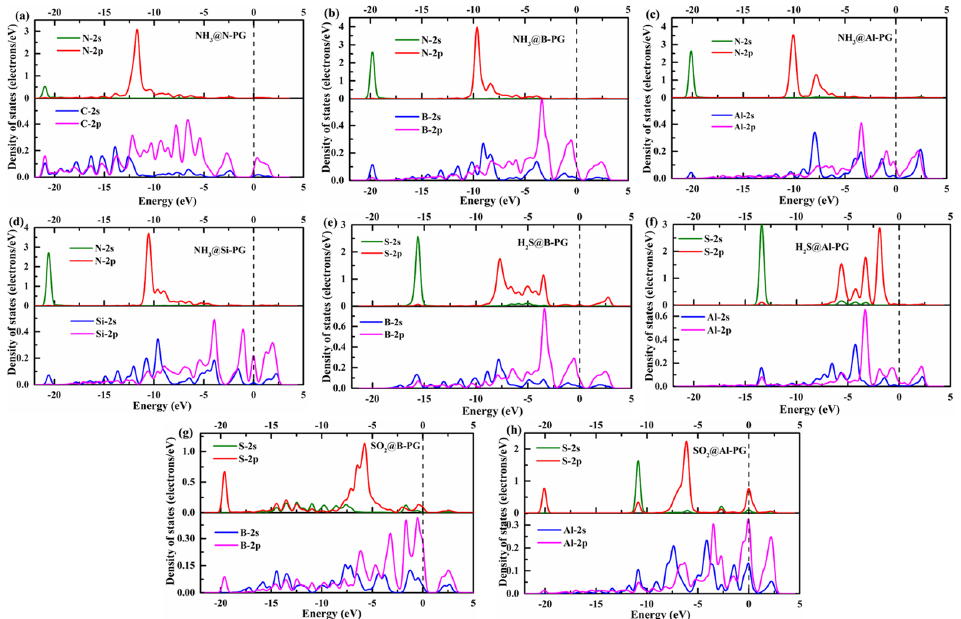
Figure 8. The DOSs of the N (S) atom of NH 3 (H 2 S/SO 2 ) and its nearest neighbor dopant atoms for various adsorption systems, ( a ) NH 3 @N-PG, ( b ) NH 3 @B-PG, ( c ) NH 3 @Al-PG, ( d ) NH 3 @Si-PG, ( e ) H 2 S@B-PG, ( f ) H 2 S@Al-PG, ( g ) SO 2 @B-PG, and ( h ) SO 2 @Al-PG. The dashed line is the Fermi level.